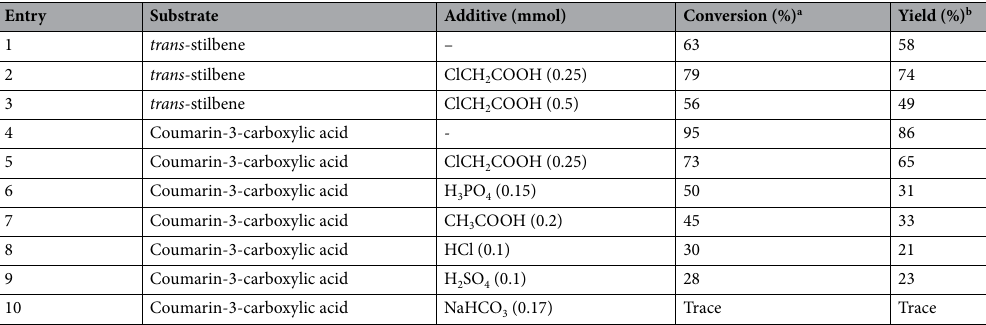
Table 4. Investigation of oxidative cleavage of trans -stilbene and coumarin-3-carboxylic acid under optimum conditions in the presence of additives. Reaction conditions: Coumarin-3-carboxylic acid/ trans